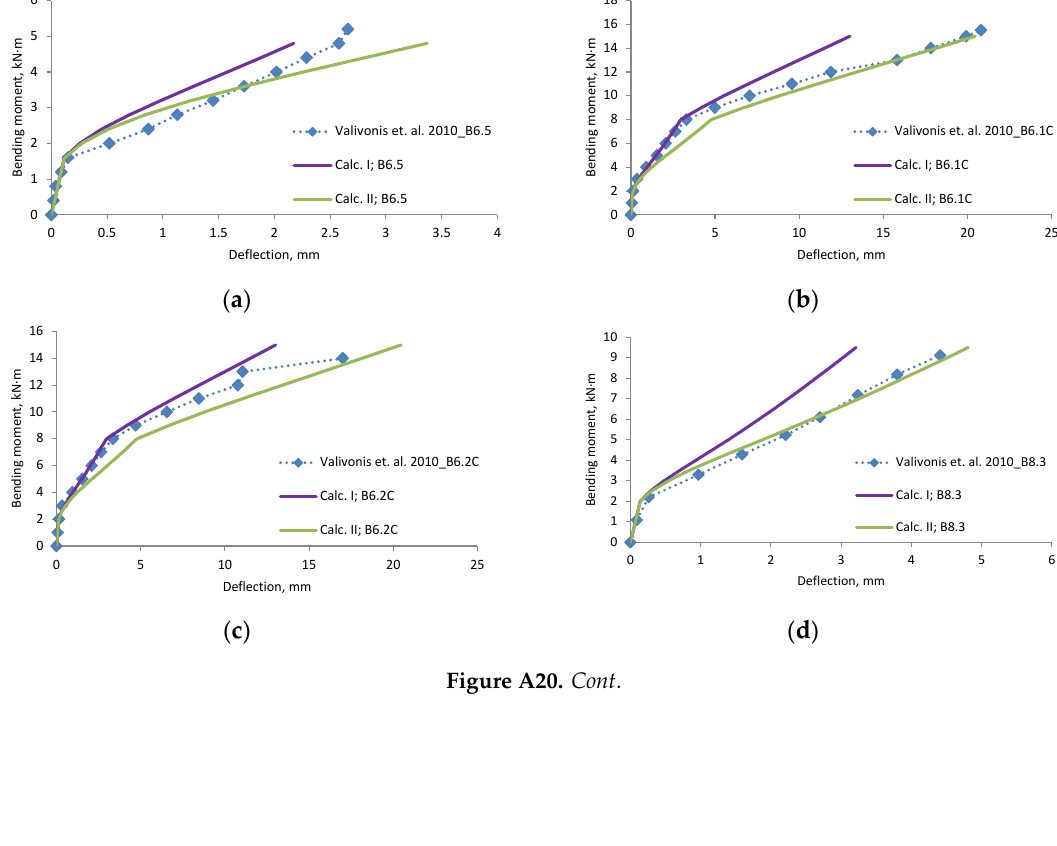
Figure A20. Cont